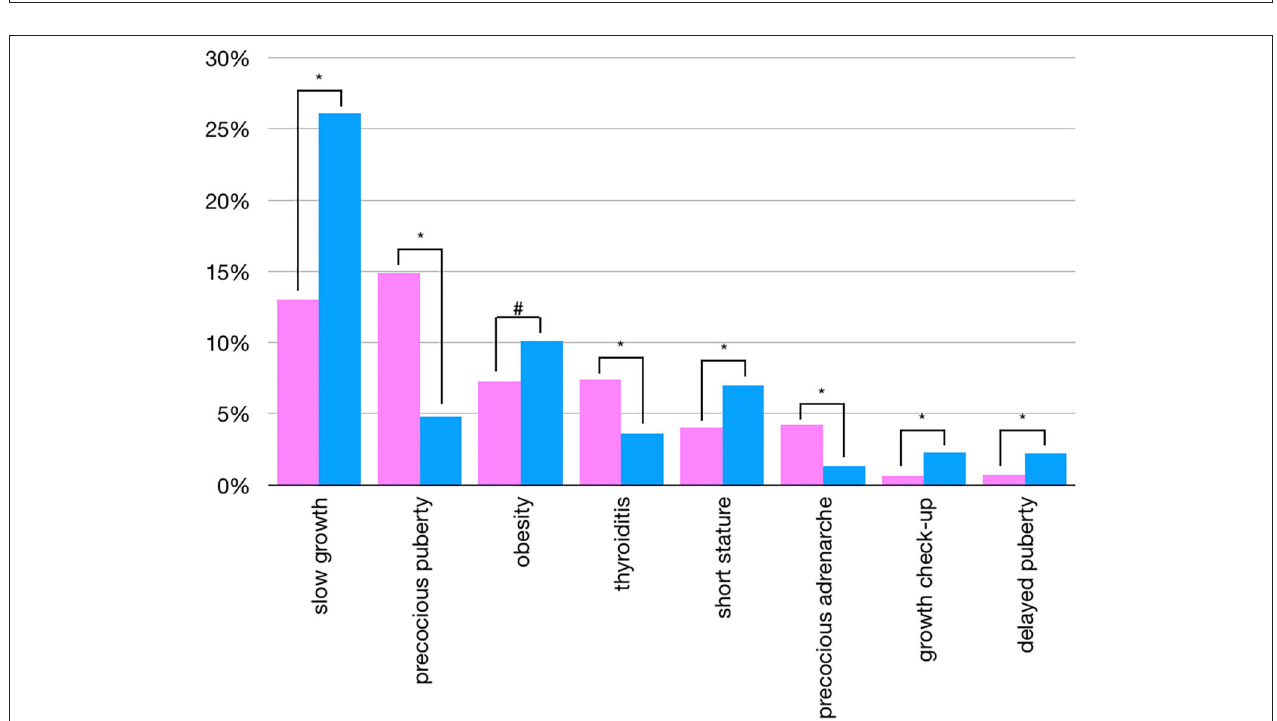
FIGURE 4 | Sex differences in overall prevalences of single referrals (pink: females; blu: males) - only statistically significant data are reported (* p < 0.01 - # p <